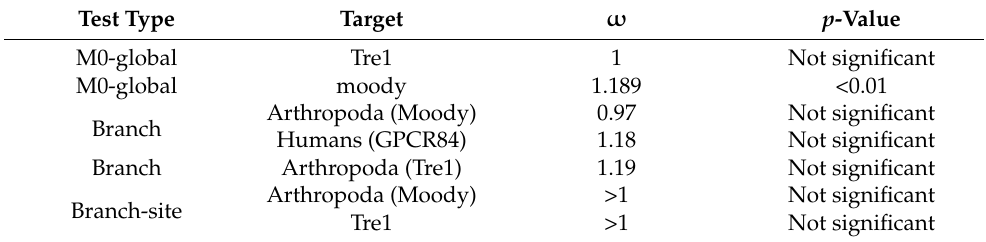
Table 1. Likelihood values and parameter estimates for Tre1 genes under positive